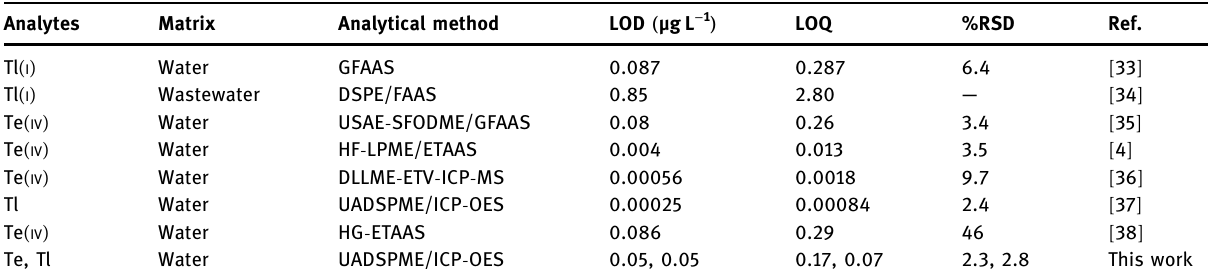
Table 6: Comparison of the analytical performance of UADSPME/ICP - OES with other analytical methods for the preconcentration and determination of Te and Tl